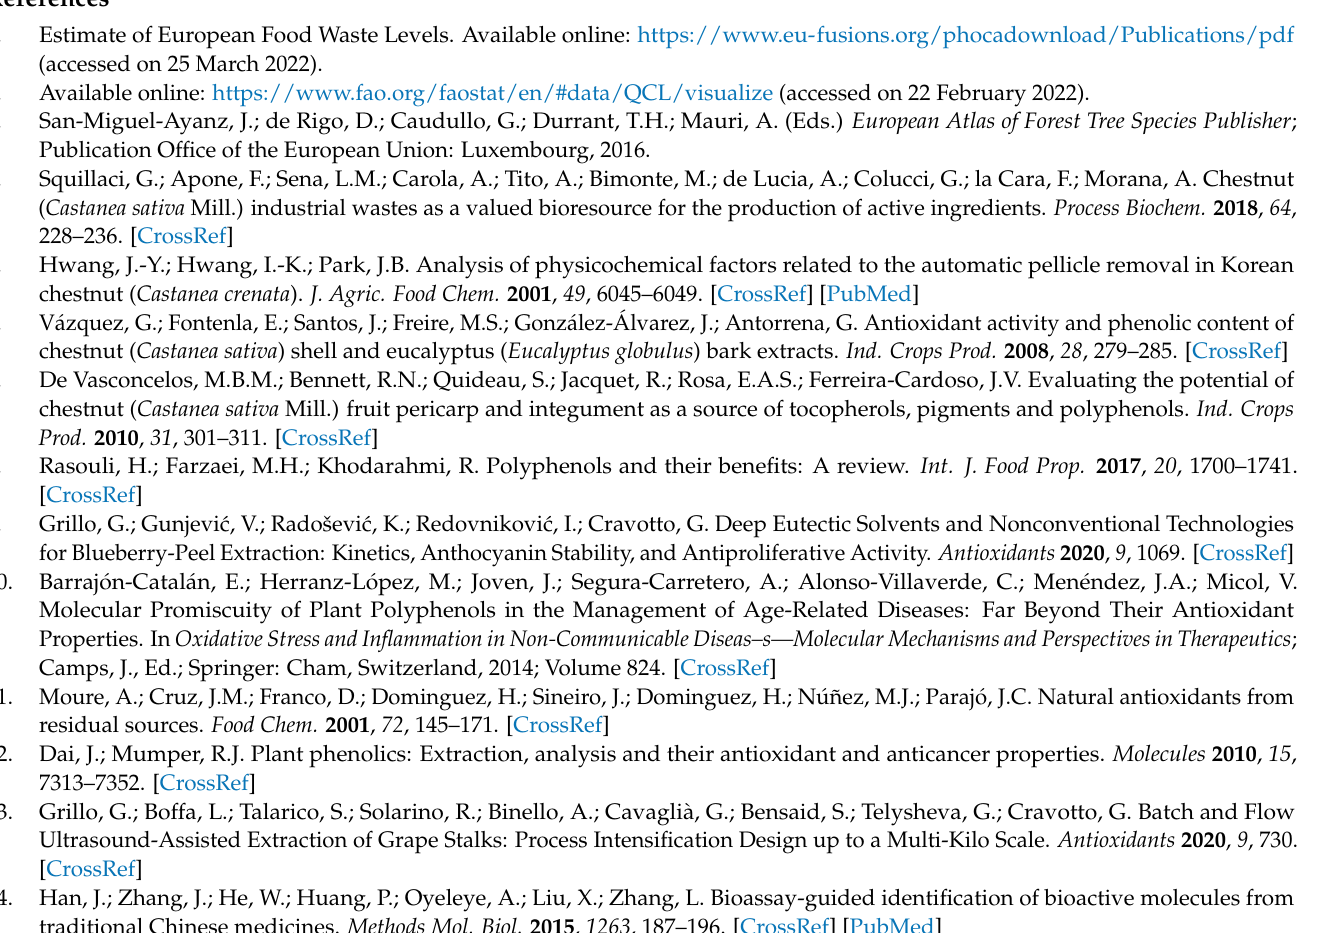
flow rate. Figure S16: Nanofiltration of chestnut extract: process concentration rate depending on permeate